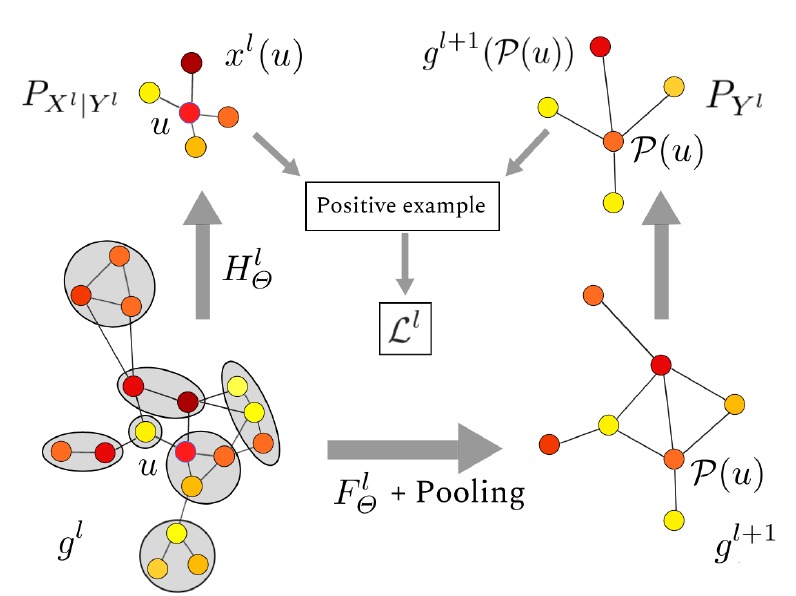
Figure 5. Single level of the pyramid. Local information x l ( u ) centered around node u is extracted from graph g l . The graph is coarsened to form a new graph g l + 1 . There, g l + 1 ( P ( u )) captures information at a larger scale, centered on node P ( u ) . The pair ( x l ( u ) , g l + 1 ( P ( u ))) is used as positive example in the negative sampling algorithm, and it helps to maximize mutual information between global and local